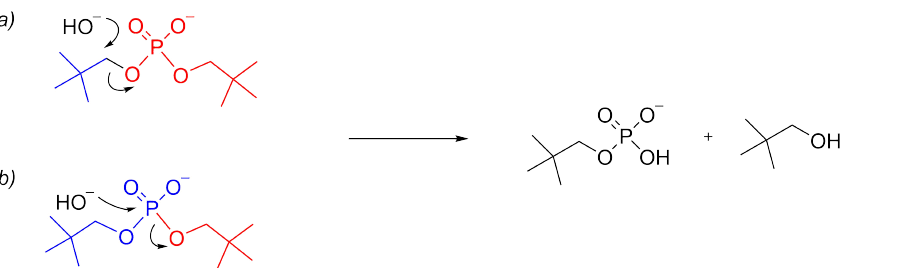
Figure 2. Schematic representation of the alternative reaction mechanisms for the cleavage of Np 2 P − : ( a ) C–O cleavage, S N 2; and ( b ) P–O cleavage, S N 2(P) or A N D N